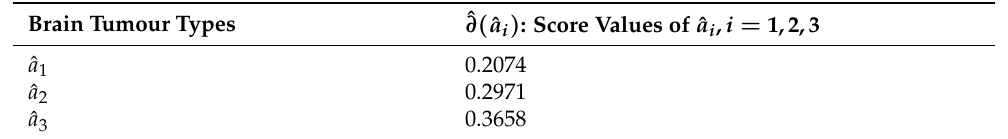
Scores of alternatives ˆ a i , i = 1,2,3 corresponding to ˆ ℘ j , j = 1,2,3,4 computed through